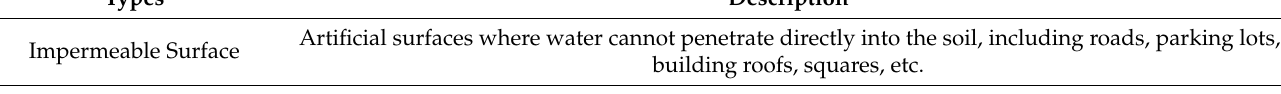
Table 1. Land use